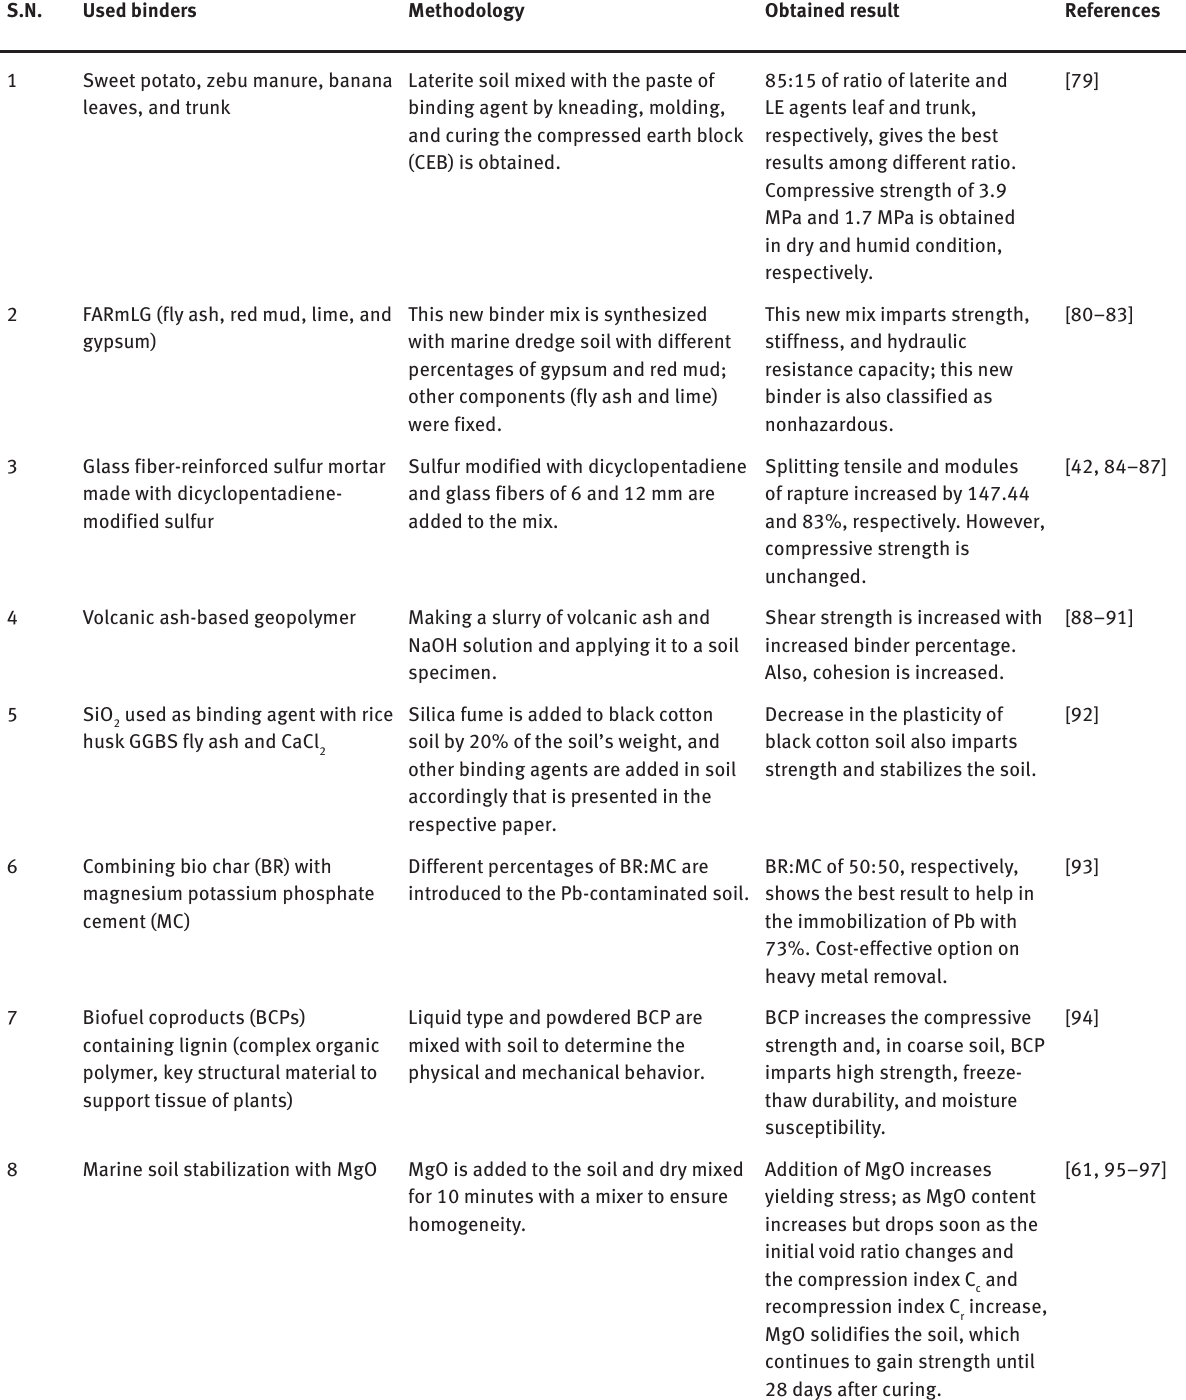
Table 5: Comparison between different methodologies applied for using different soil binders by previous researchers and their obtained results source: